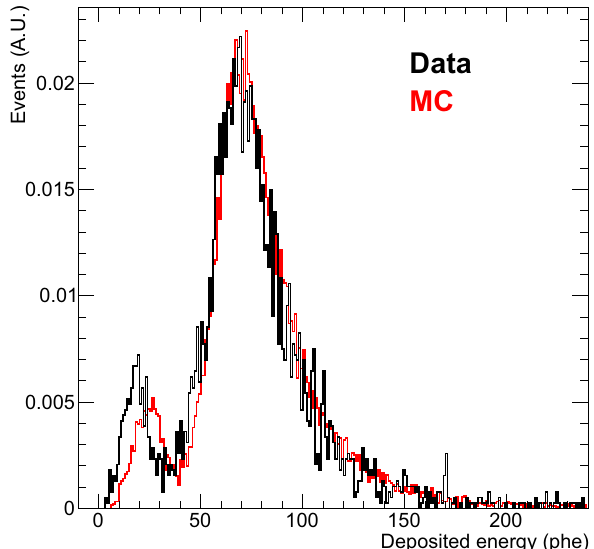
Fig. 19 Distribution of the total energy released in the ECal. Differ- ent colors refer to the different anti-coincidence selections: black - all events, red OV-anti-coincidence, green IV-anti-coincidence, blue both veto